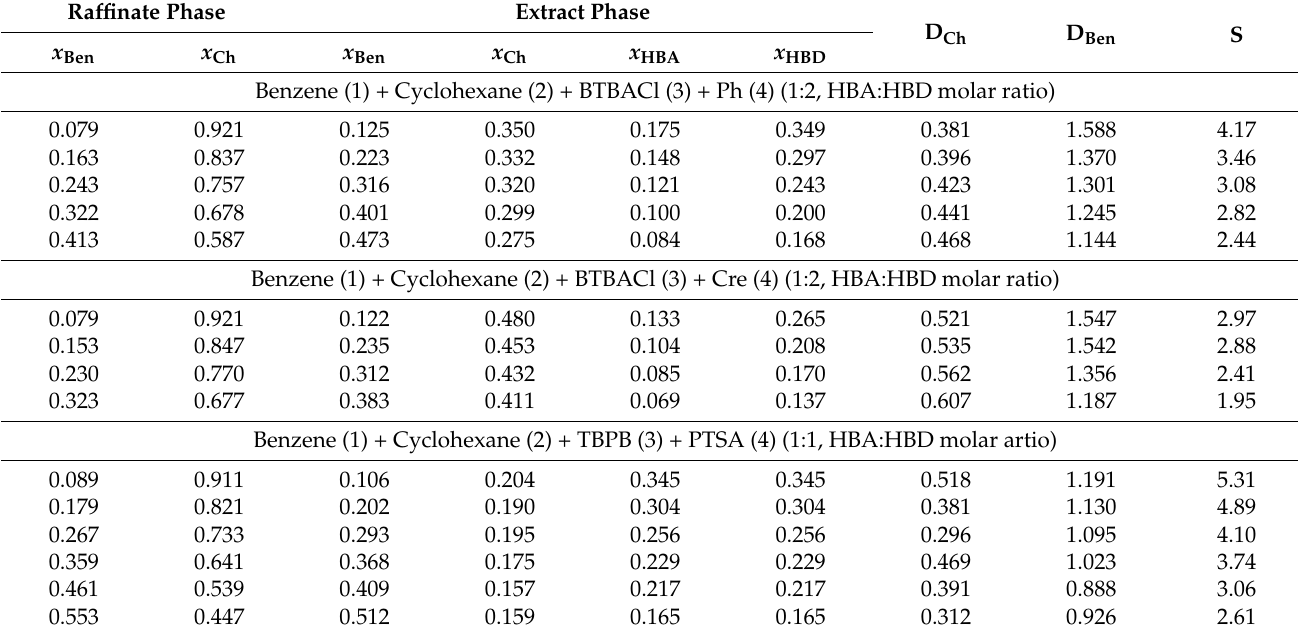
Table 1. Molar composition of experimental tie-lines, distribution ratio (D), and selectivity (S) data for three systems at 101.325 kPa and T = 298.15